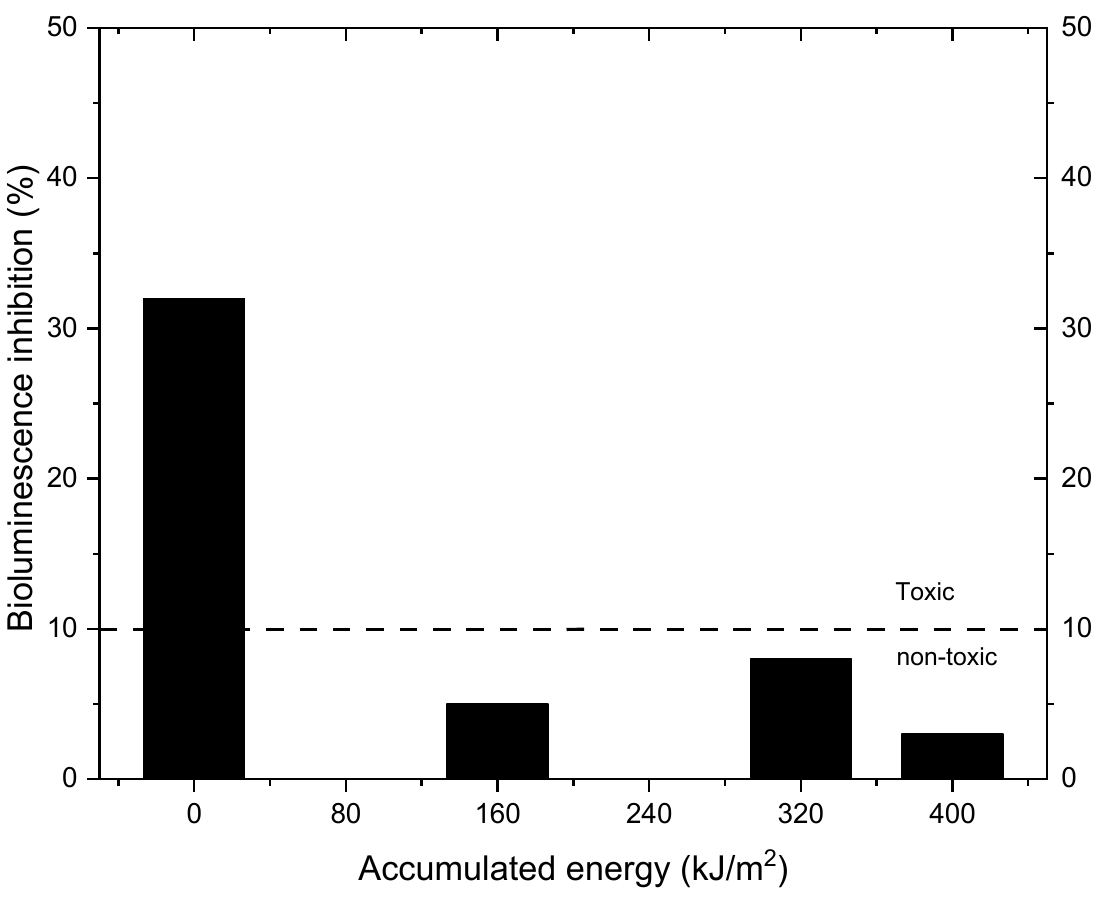
Figure 8. Evolution of the toxicity during photocatalytic treatment of E3 using the B-TiO 2 3wt.% catalyst, expressed as the luminescence inhibition (%) of the bacteria Vibrio fischeri . The test revealed an initial inhibition of 32% of V. fischeri bioluminescence (0 kJ/m 2 accumulated energy), indicating that the initial solution with estriol was toxic. According to Mexican regulations (NMX-AA-112-SCFI-2017) [51], a bioluminescence inhibition higher than 10% in contrast to the control sample indicates that the sample is toxic; sam- ples with less than 10% inhibition are categorized as non-toxic. The bioluminescence inhi- bition values during the E3 degradation decreased to 5, 8, and 3% at 160, 320, and 400 kJ/m 2 of the accumulated energy, respectively, using the B-TiO 2 3 wt.% catalyst, demon- strating that a non-toxic solution is attained from 160 kJ/m 2 of accumulated energy. 3. Material and Methods 3.1. Chemicals